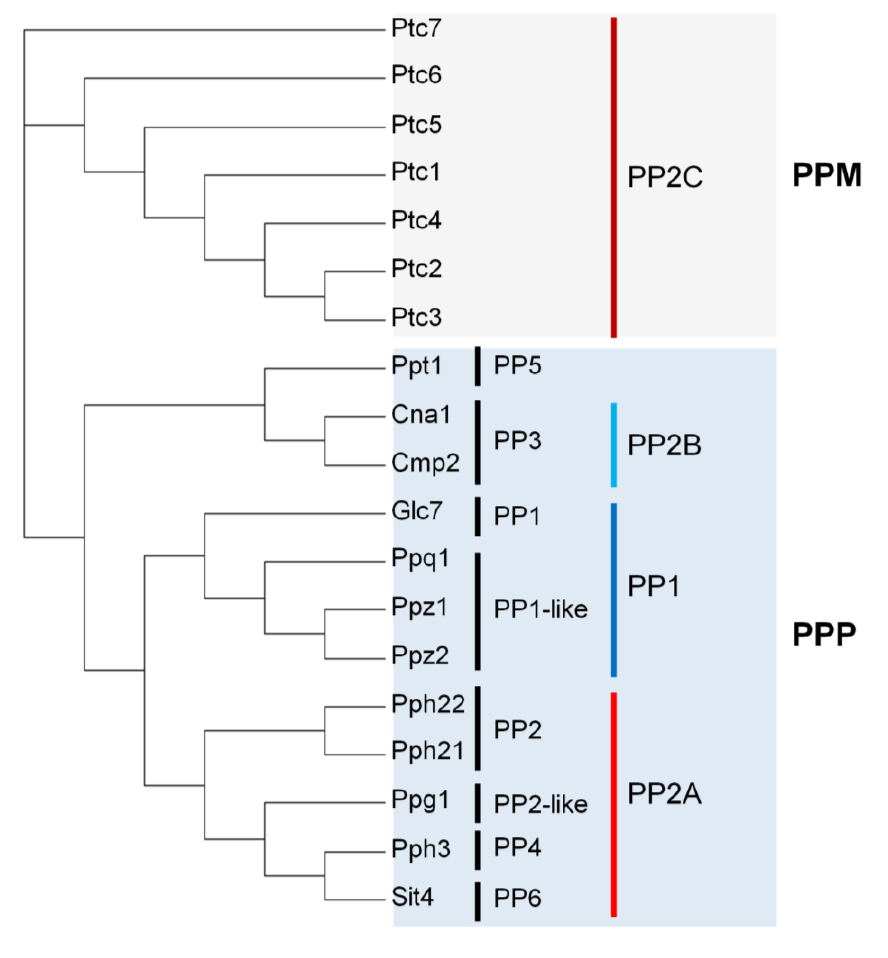
FIGURE 1: Phylogenetic analy- sis of protein phosphatase sequences from S.